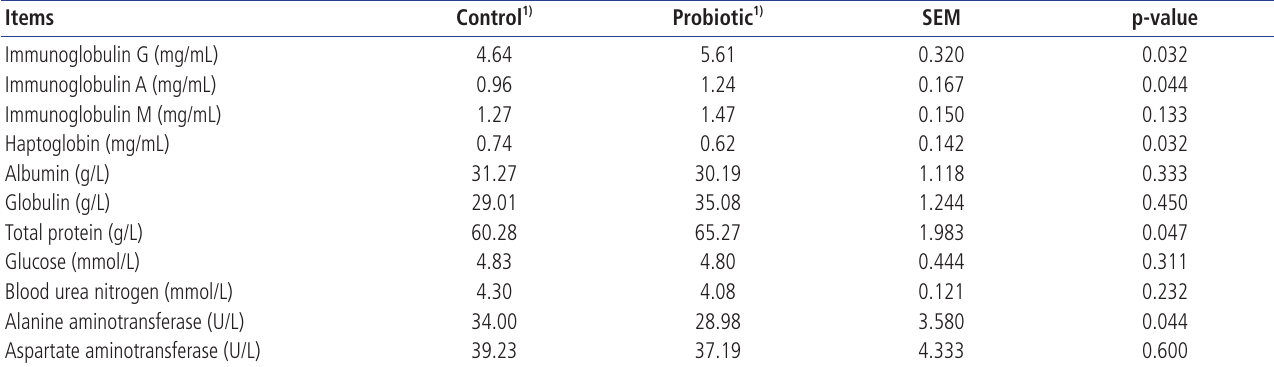
SEM, standard error of means; CFU, colony-forming unit. 1) Control, control diet; Probiotic, control diet supplemented with Pediococcus acidilactici ZPA017 (2.40×10 9 CFU/kg of diets).